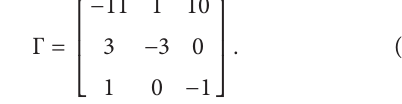
switching from one to another according to the movement of Markov chain 𝑟(𝑡)